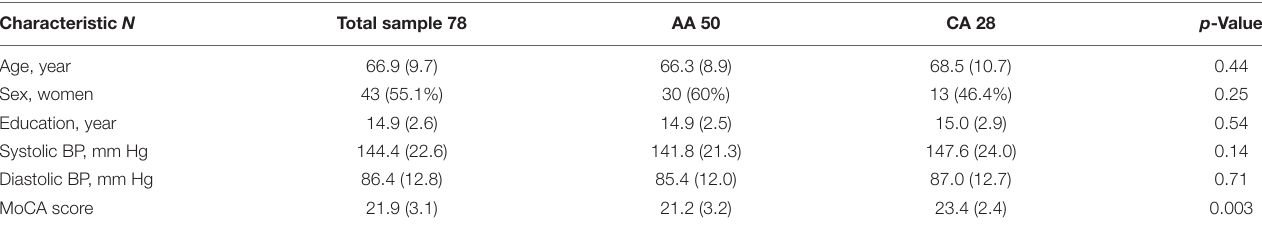
TABLE 1 | Mean scores (standard deviations) and statistical comparison between the African–Americans (AA) and the Caucasian–Americans (CA) regarding their age, sex, education, blood pressure (BP), and Montreal cognitive assessment (MoCA) score. Characteristic N